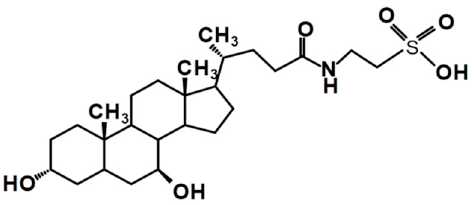
Figure 1. Chemical structure of tauroursodeoxycholic acid, TUDCA.